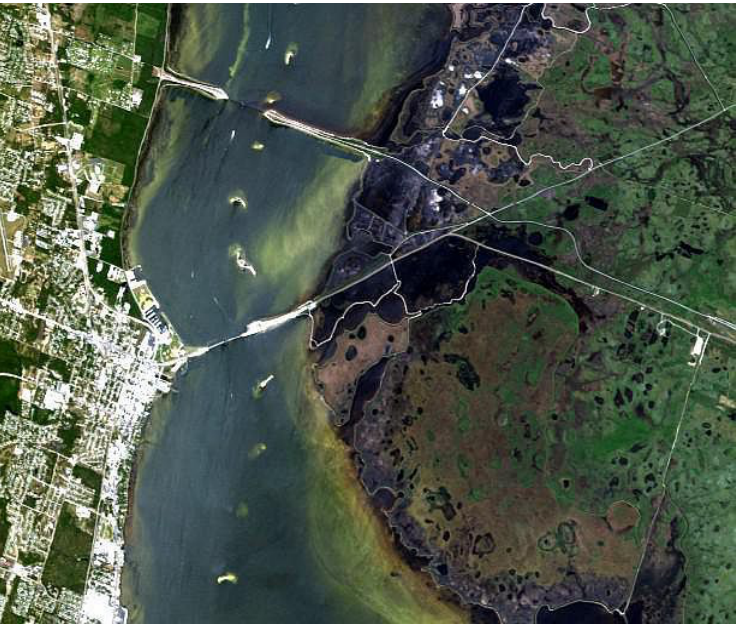
Fig.1 The synthesis true color image (bands 31, 21, 11) of AVIRIS data